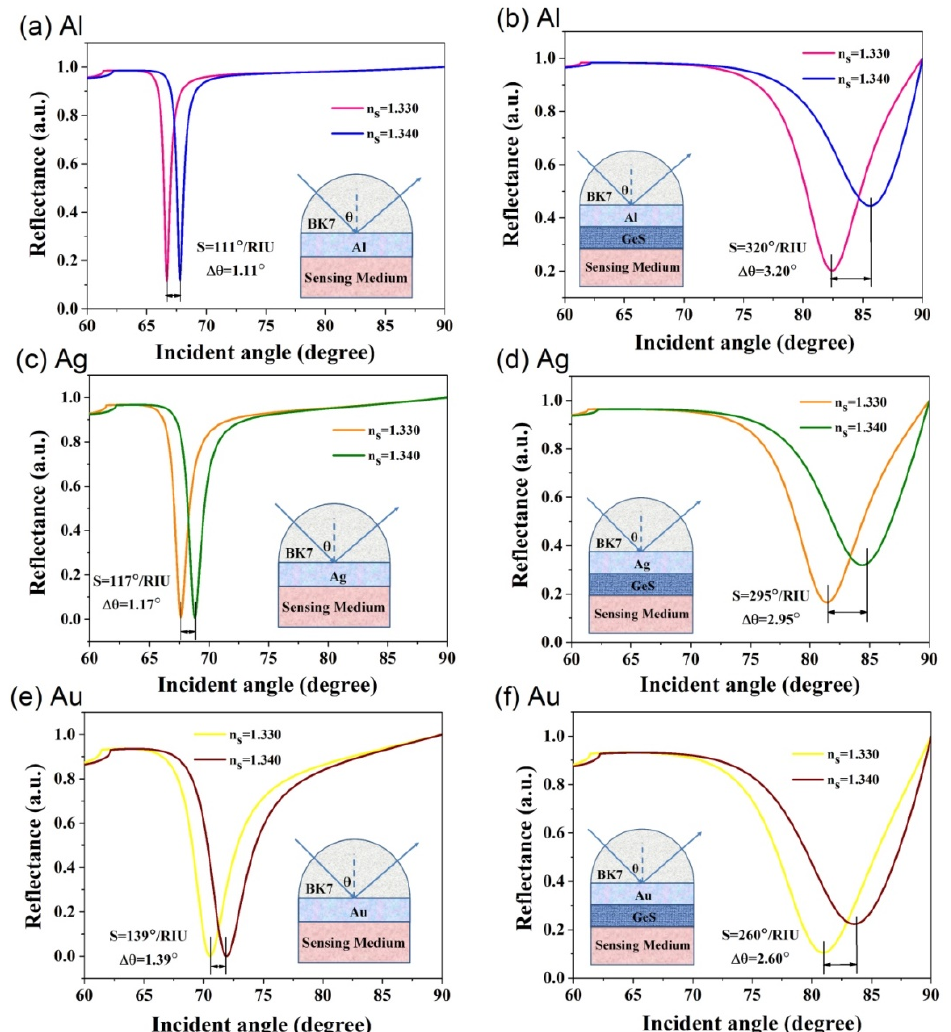
Figure 3. ( a , c , e ) The incident angle reflectance change of the conventional sensors with single Al/Ag/Au metal layer, and ( b , d , f ) The incident angle reflectance change of the sensors with GeS on top of Al/Ag/Au metal layer.